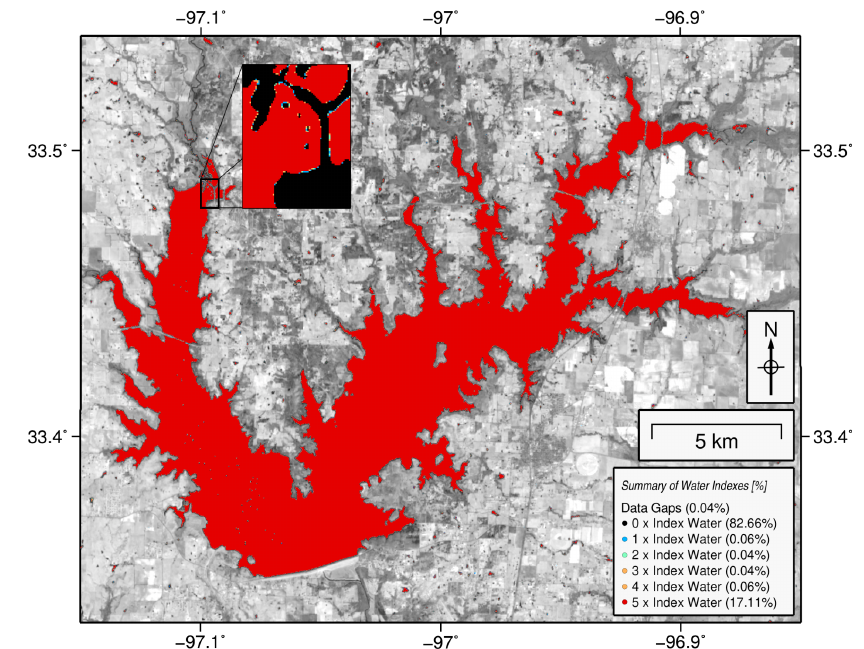
Figure 9. Combination of all land-water masks using five different water indexes for Lake Ray Roberts in January